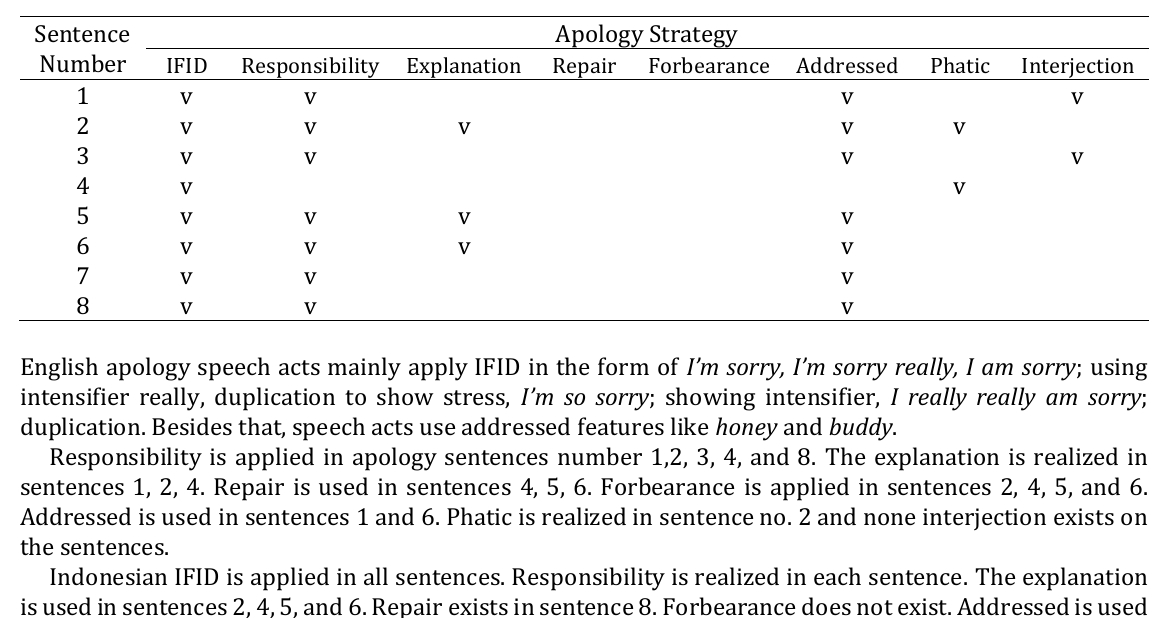
Table 2 Apology Strategy on TV Sitcom Office